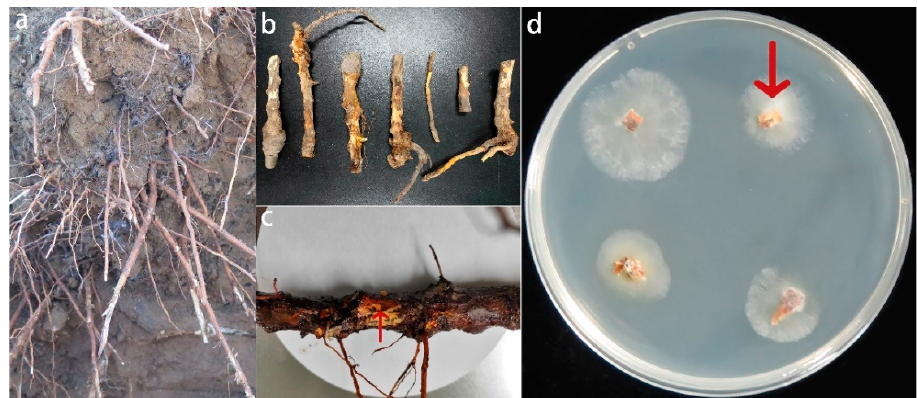
Figure 1. Diseased roots ( b , c ) collected from apple trees replanted from old orchards ( a ), the junction between diseased and healthy tissues on the bast of diseased roots has been marked with arrows ( c ), and fungal cultures grown from the junction between diseased and healthy tissues on PDA after 2–3 days at 28 °C, where the fungal culture indicated by the arrow is the subsequent isolation and identification of the Fusarium solani isolate HBH 08 ( d ).